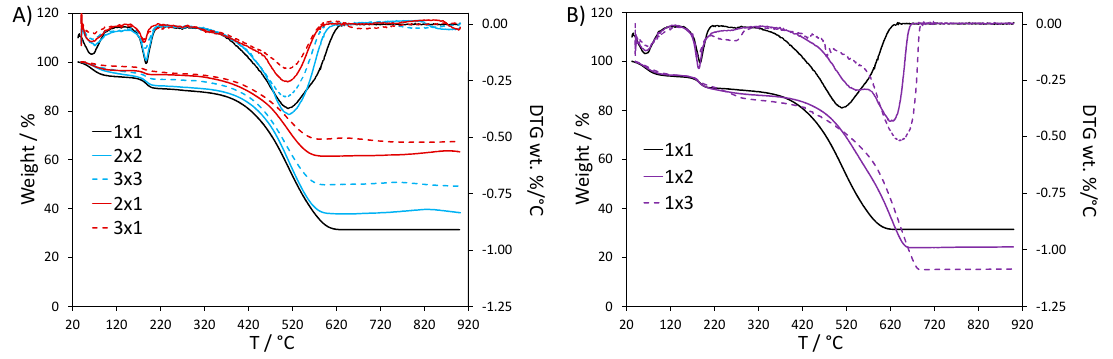
Figure 1. TGA and DTG curves of PANI-TiO 2 nanocomposites: ( A ) e ff ect of TiO 2 quantity and ( B ) e ff ect of H 2 O 2 amount.